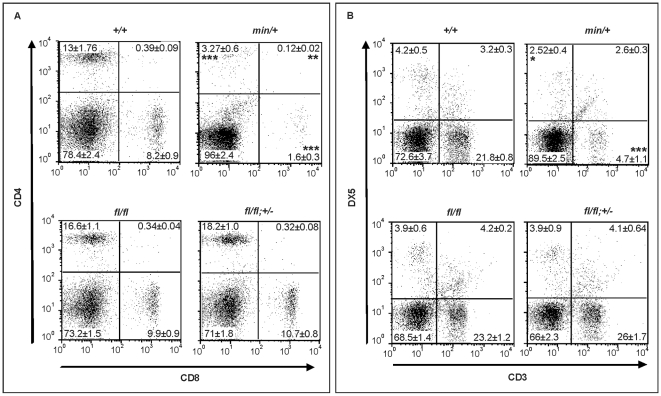
Lymphodepletion in Apc hypomorphic mice.(A) Flow cytometry analysis of CD4+/CD8+ stained splenocytes from 17 week old mice of the indicated genotypes. Representative results from one individual mouse are shown with the percentages contribution to each quadrant shown as Mean ± SD from at least 3 mice. (B) Flow cytometry analysis of CD3+/DX5+ stained splenocytes from 17 week old mice of the indicated genotypes. The NK cell population (DX5+;CD3−) are within the top left gate, and the bottom gates contain CD3+ T cells. Representative results from one individual mouse are shown with the percentages contribution to each quadrant shown as Mean ± SD from at least 3 mice. Genotypes are as follows: wild-type (+/+); Apcmin/+ (min/+); Apcfl/fl (fl/fl); Apcfl/fl;Ctnnb1+/− (fl/fl; +/−). All mice were on a mixed genetic 129Sv x C57BL/6 background.